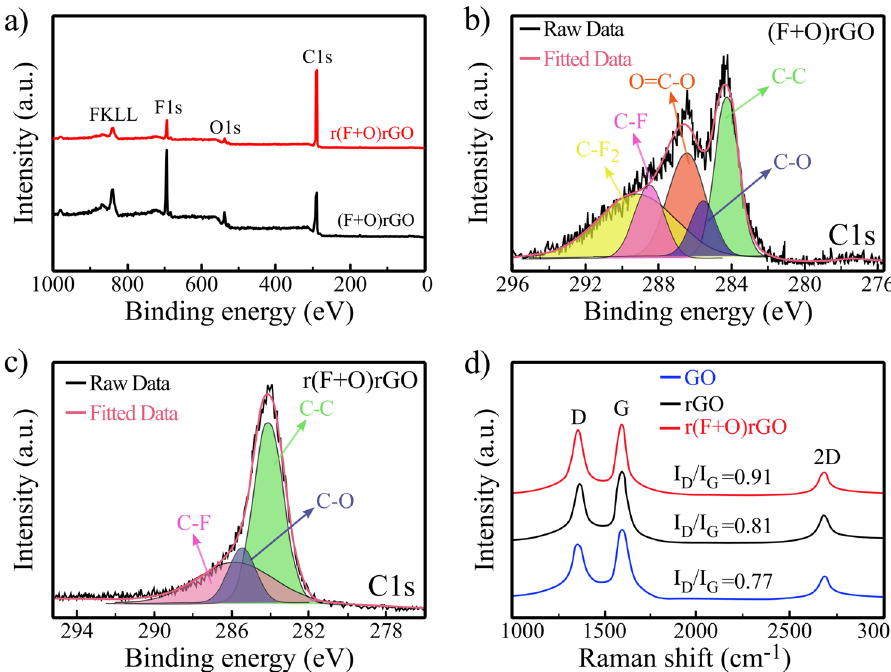
Figure 5. ( a ) XPS survey spectra of (F + O)rGO, and r(F + O)rGO samples. ( b ) The C1s XPS spectrum of the (F + O)rGO sample. ( c ) The C1s XPS spectrum of the r(F + O)rGO sample. ( d ) Raman spectra of the GO and rGO and r(F + O)rGO